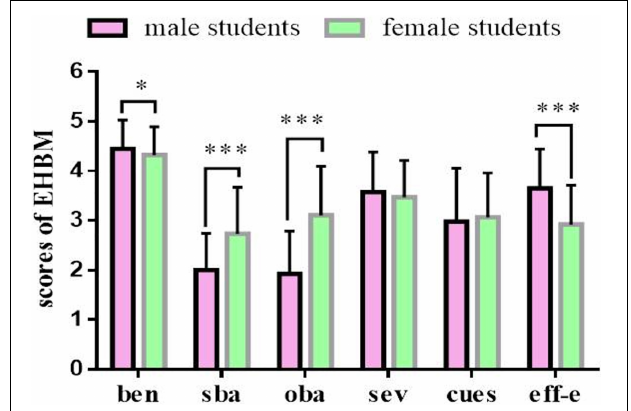
FIGURE 1 | Compared with female college students, male students had higher in perceived benefits and self-efficacy, and lower in perceived subjective barriers and objective barriers. ben, perceived benefits; sba, perceived subjective barriers; oba, perceived objective barriers; sev, perceived severity; cues, cues to action; eff-e, exercise self-efficacy. ∗ p < 0.05, ∗∗∗ p < 0.001.